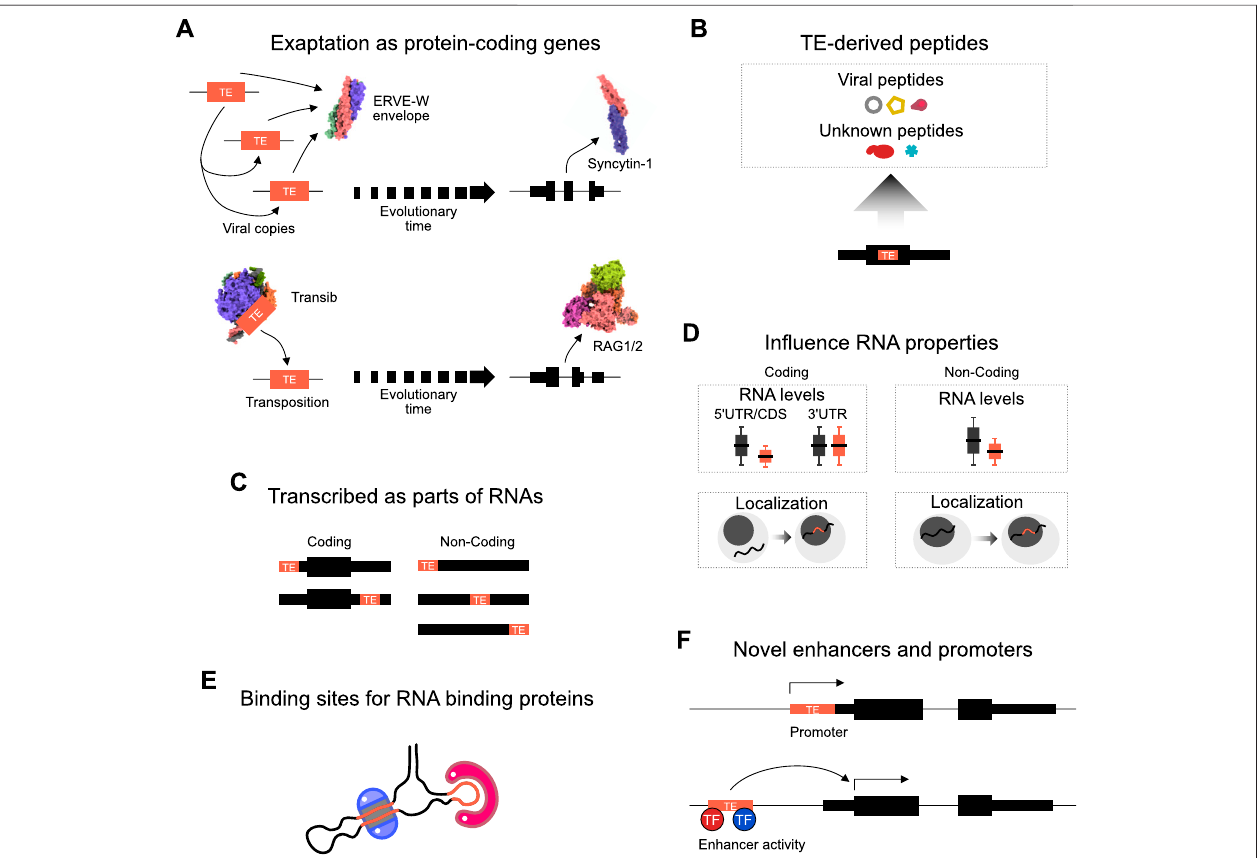
FIGURE1| MechanismsofTEactivity. (A) Schematicoftwoexamplesoftheexaptation oftransposable element codingsequencesasprotein-codinggenes.TEs randomly duplicate themselvesin the genome, and eventually over evolutionarytimeone TEcopy is exapted for biological function. A HERVW envelope protein became Syncytin, and a Transib became RAG1/2 in the immune system. Structures are from 1qbz (SIV gp41) (Yang et al., 1999), 5ha6 (Syncytin-1), 6pr5 (HzTransib) (Liu et al., 2019),4wwx(RAG1/2)(Kimetal.,2015). (B) TEsinsertedintocodingframescanalsogiverisetoTE-derivedpeptidefragments.SomematchtoknownTEpeptide sequences, for example, LINE ORFs, or ERV gag, pol, env proteins, yet other proteins have no match. (C) TEs can be transcribed as parts of coding or non-coding RNAs. In coding transcripts, most TEs are part of the 5 ′ or 3 ′ untranslated regions (UTR). In non-coding transcripts, TEs can be embedded anywhere inside the transcript,and non-codingtranscripts oftencontainmultiple differenttypes ofTE. (D) The presence ofTEsinsidean RNAsequence impacts propertiesofthetranscript. For example, TEs tend to lead to reduced expression in non-coding transcripts, but only reduce coding RNAs when the TE is present in the 5 ′ UTR or coding sequence (CDS). The presence of a TE in both coding and non-coding transcripts uniformly leads to increased retention of the transcript in the nucleus. (E) TEs can form binding sites for the recognition of and binding by RNA binding proteins. RNAs fold up to form hairpins and complex structures which are recognized by sequence or structure- speci fi c RBPs. (F) TEs, when inserted into the genome can lead to the evolution of novel enhancers or promoters. TEs contain promoters to promote their expression (and so enhance their ability to colonize the genome). However, TEs can also form novel promoter transcription start sites. TEs also contain transcription factor binding sites that can recruit endogenous transcription factors (TFs) to activate nearby gene